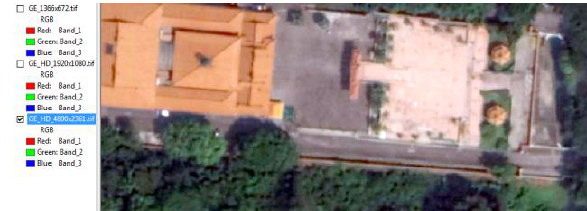
Figure 12c. Maximum resolution (4800 x 2361) - Clearest image